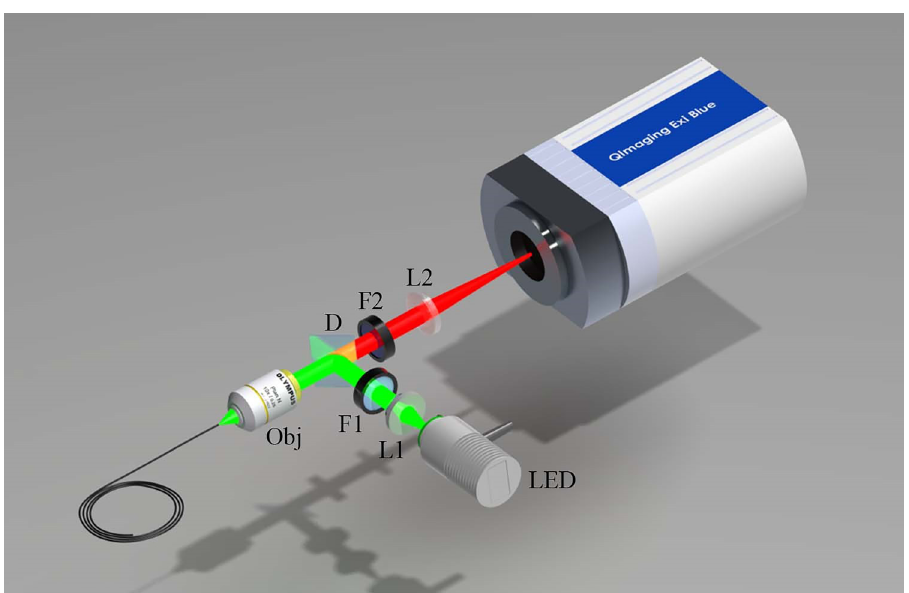
Fig 1. Illustration of the microendoscope system. LED: light emitting diode; L1: collimating lens; F1: excitation filter; D: dichroic beamsplitter; Obj: Microscope objective; F2: Emission filter; L2: focusing lens; FB: fiber